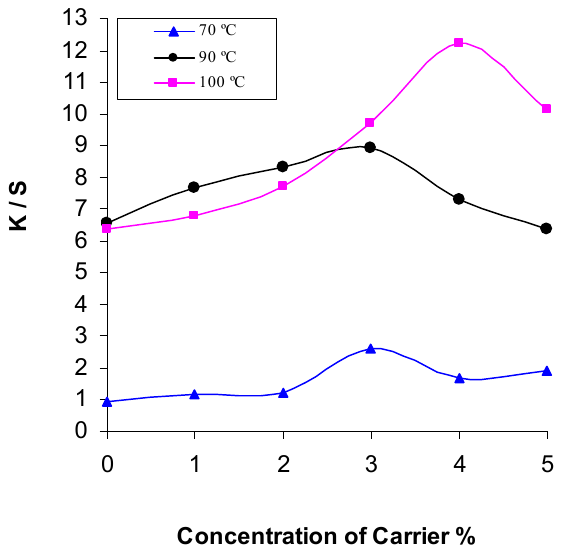
Figure 1 . Effect of the concentration of carrier on the dyeing for disperse dye 3a at different dyeing temperatures.